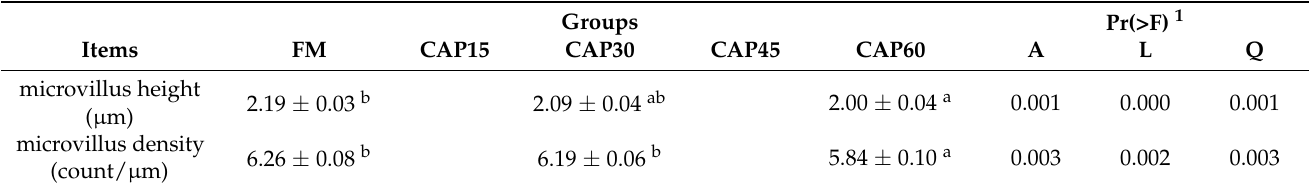
Figure 2. TEM of distal intestines of pearl gentian grouper-fed gradient substitution of fishmeal in the diet with CAP (magnification = 6000, Scale size = 1 μm). Table 8. Distal intestinal morphological histology of pearl gentian grouper fed gradient substitution of fishmeal in the diet with CAP